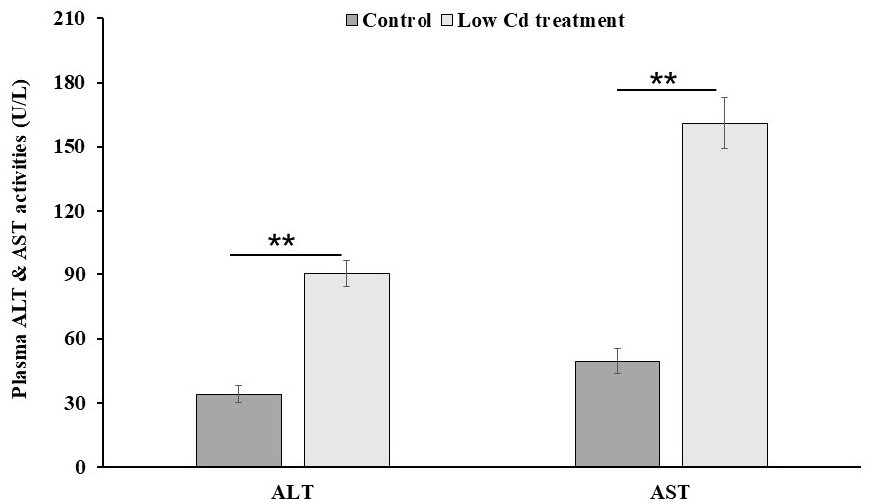
Figure 9. The activities of alanine aminotransferase (ALT) and aspartate aminotransferase (AST) in serum samples from the control and low Cd treatment groups. ** p < 0.01.